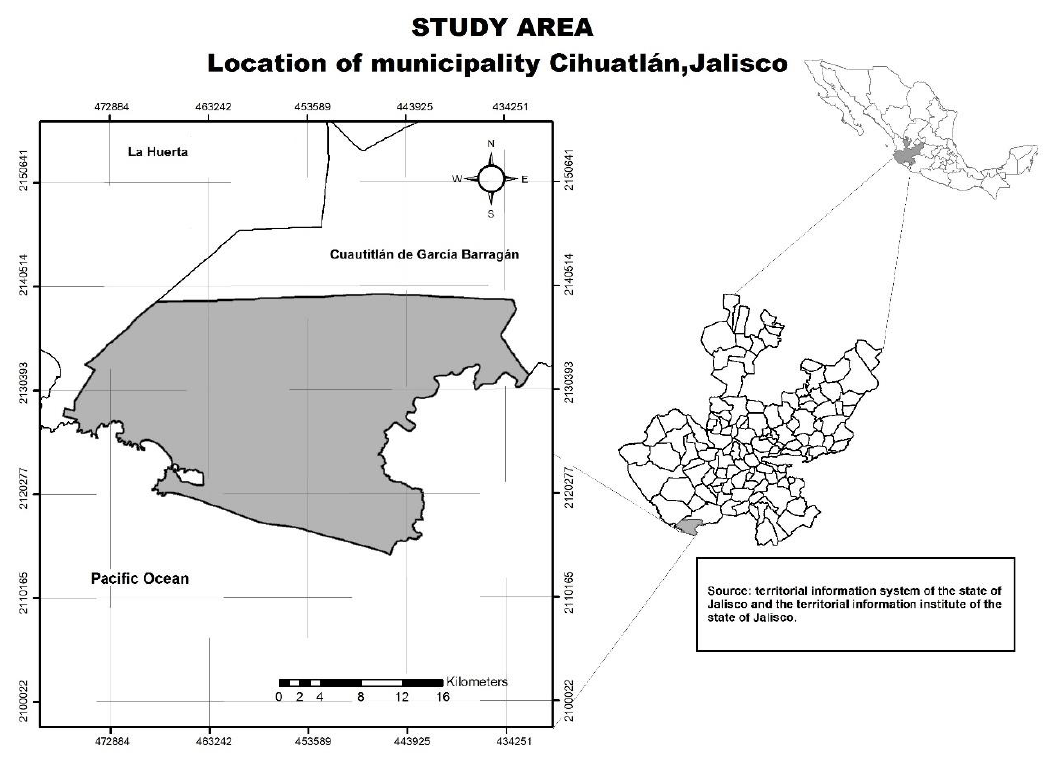
Figure 1. Location of the study area (municipality of Cihuatlán).